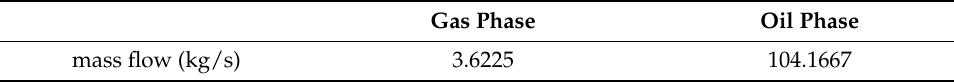
Table 2. Mass flow of the inlet.